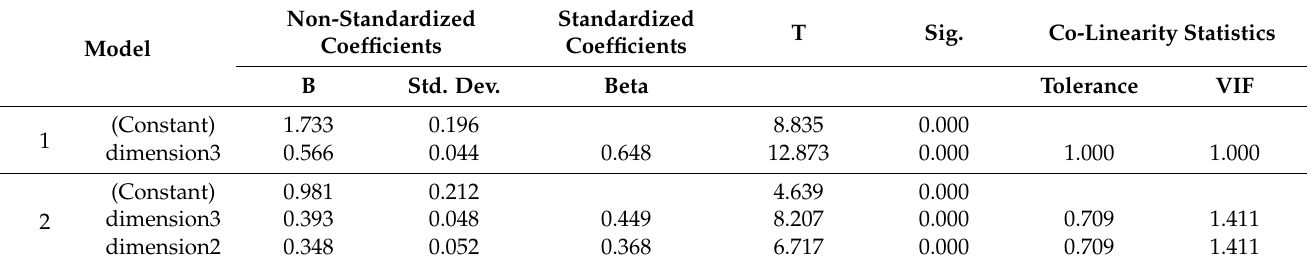
Table 6. Coefficient of the regression line for the dependent variable “VESS